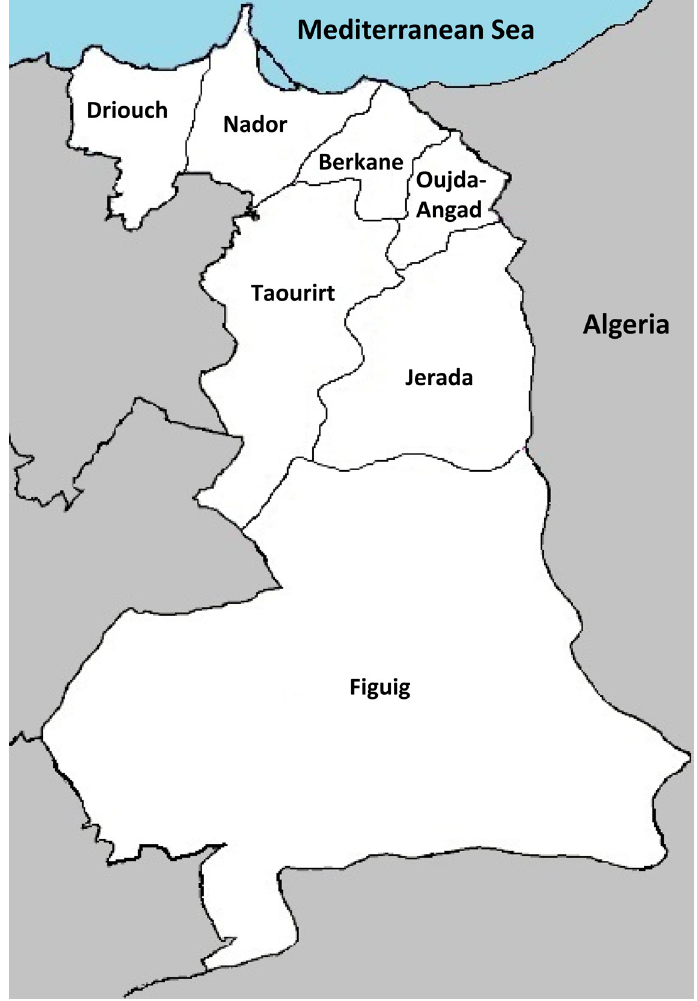
Fig 1. Schematic representation of Eastern Morocco region. Adapted from the High Commission for Planning 2012 document, see http://www.hcp.ma/region-oriental/docs/monographieFr2012/monographie%